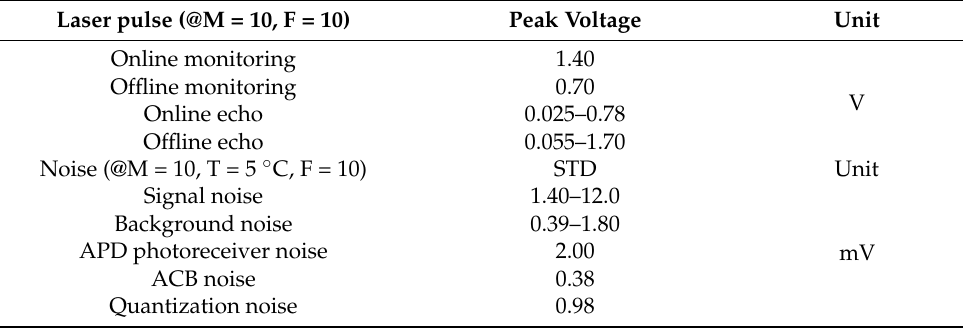
Figure 17. ( a ) Global signal noise distribution of online echo signal. ( b ) Global signal noise distribution of offline echo signal. ( c ) Global background noise distribution. Table 2. The values of four signals and all noise sources at M = 10, T = 5 °C and F = 10.